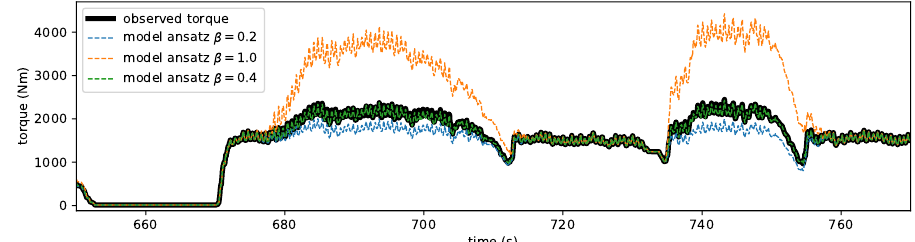
Figure 11. Comparison between the observed crusher torque and the expected torque for different model parameters of the ansatz s = h β for the MWD–hardness relation. When the deviation is small ( β ≈ 0.4), the model is calibrated. In the presented period, four truck loads reach the crusher, two from the left source with harder ore and two from the right